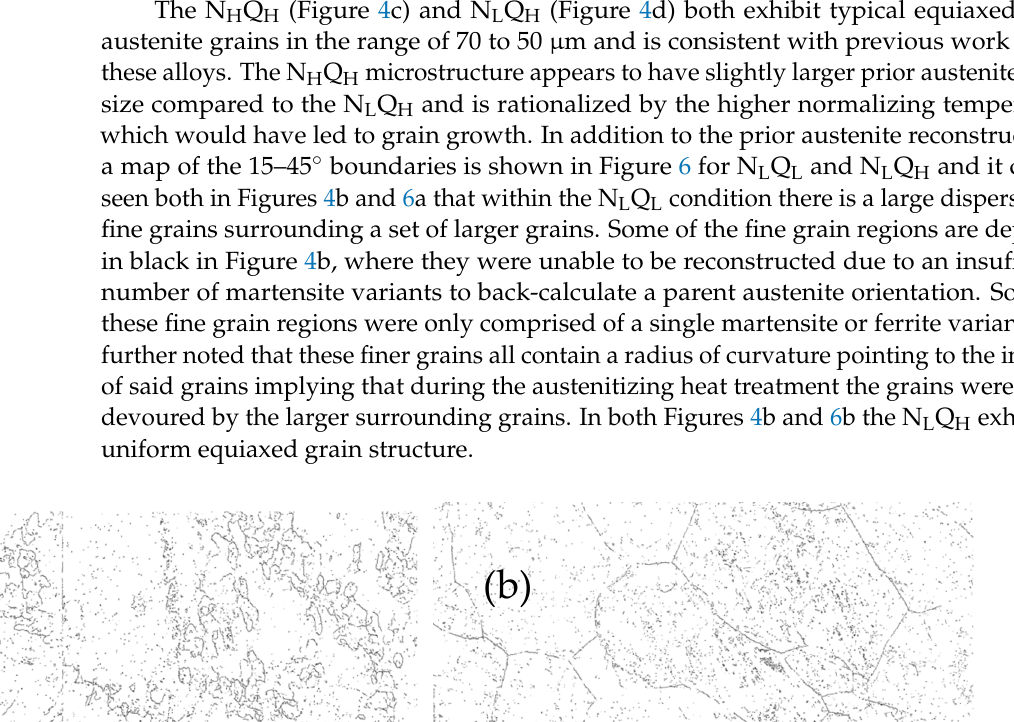
L Q L and ( b ) N L Q H